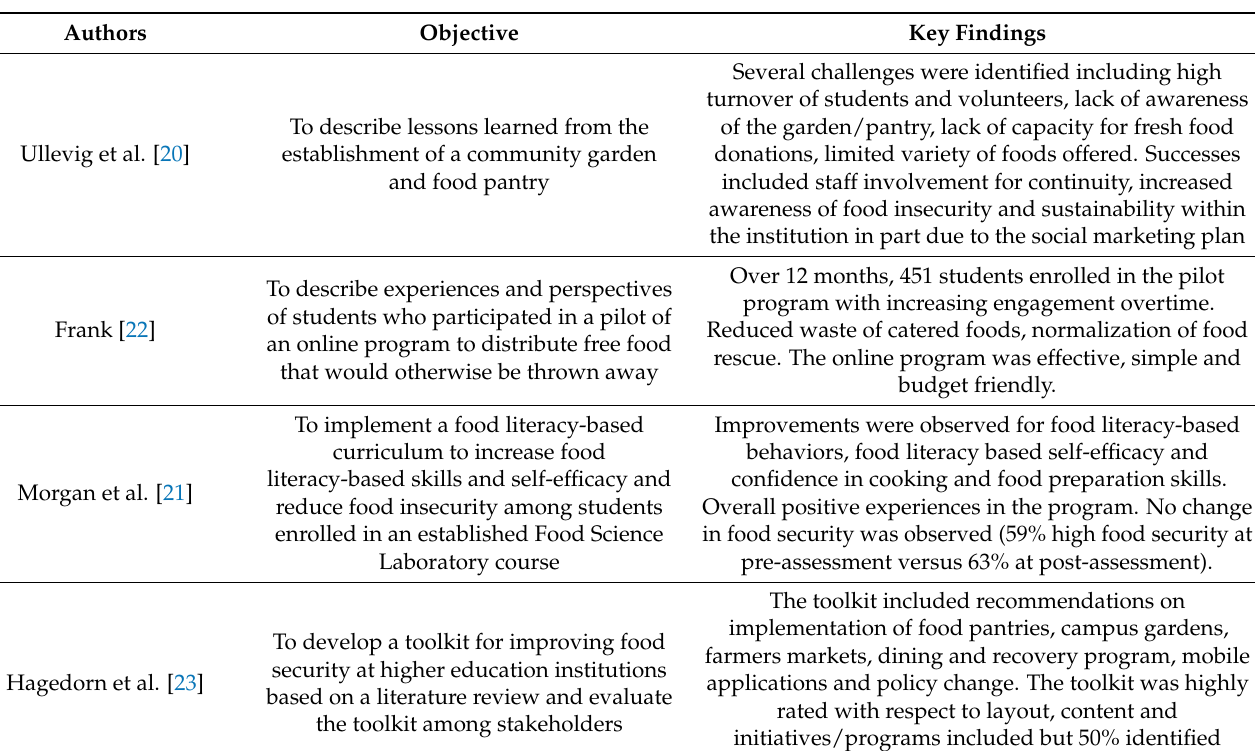
Table 2. Key findings of included